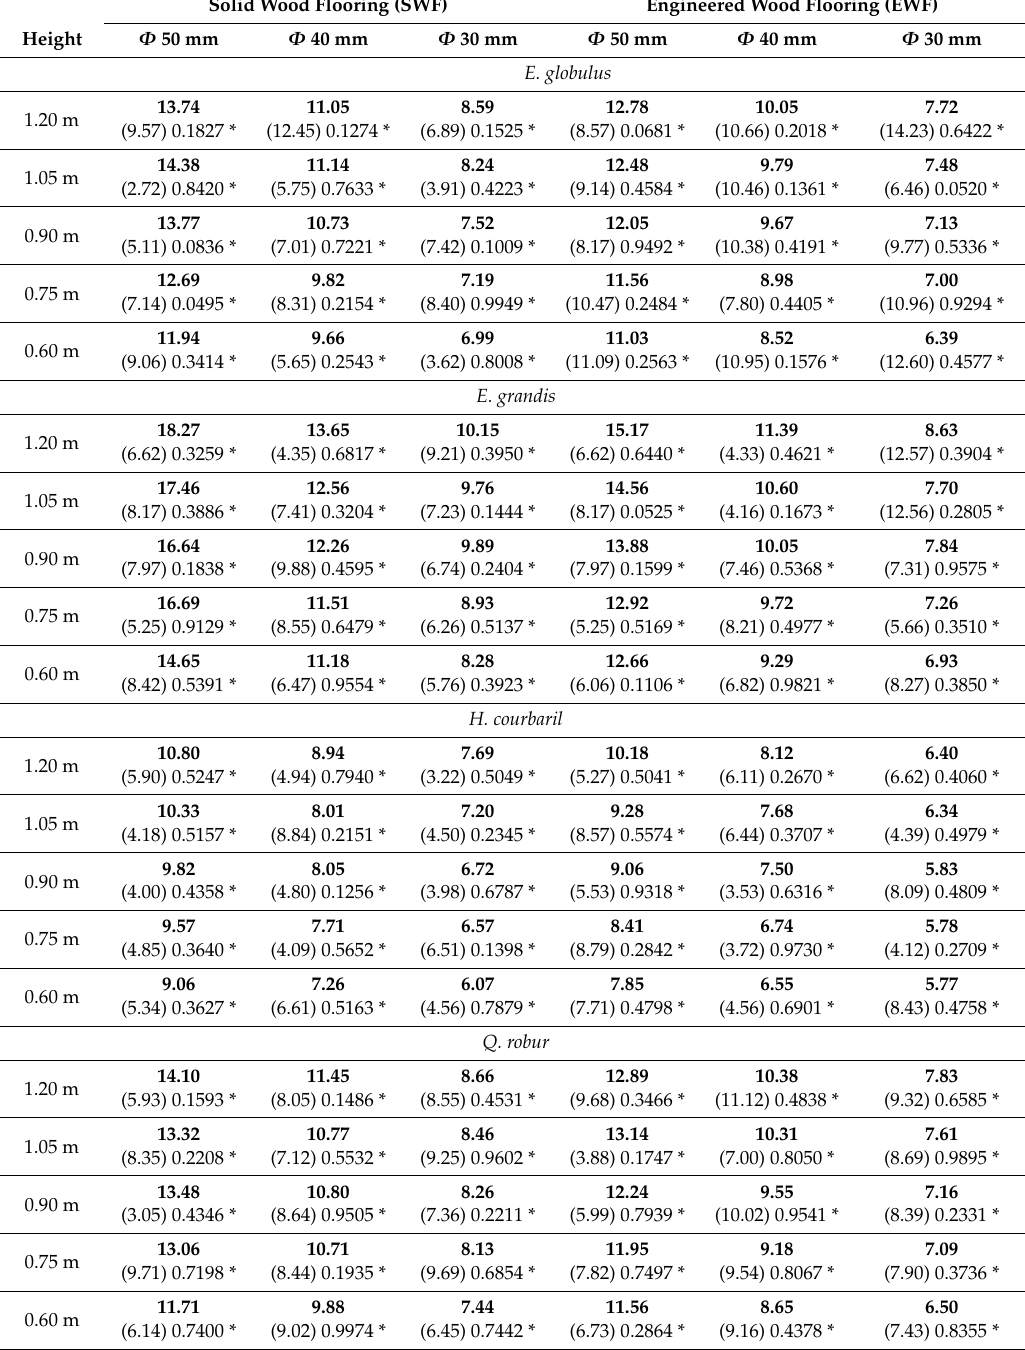
Table 3. Footprint diameter (FD). Main descriptive